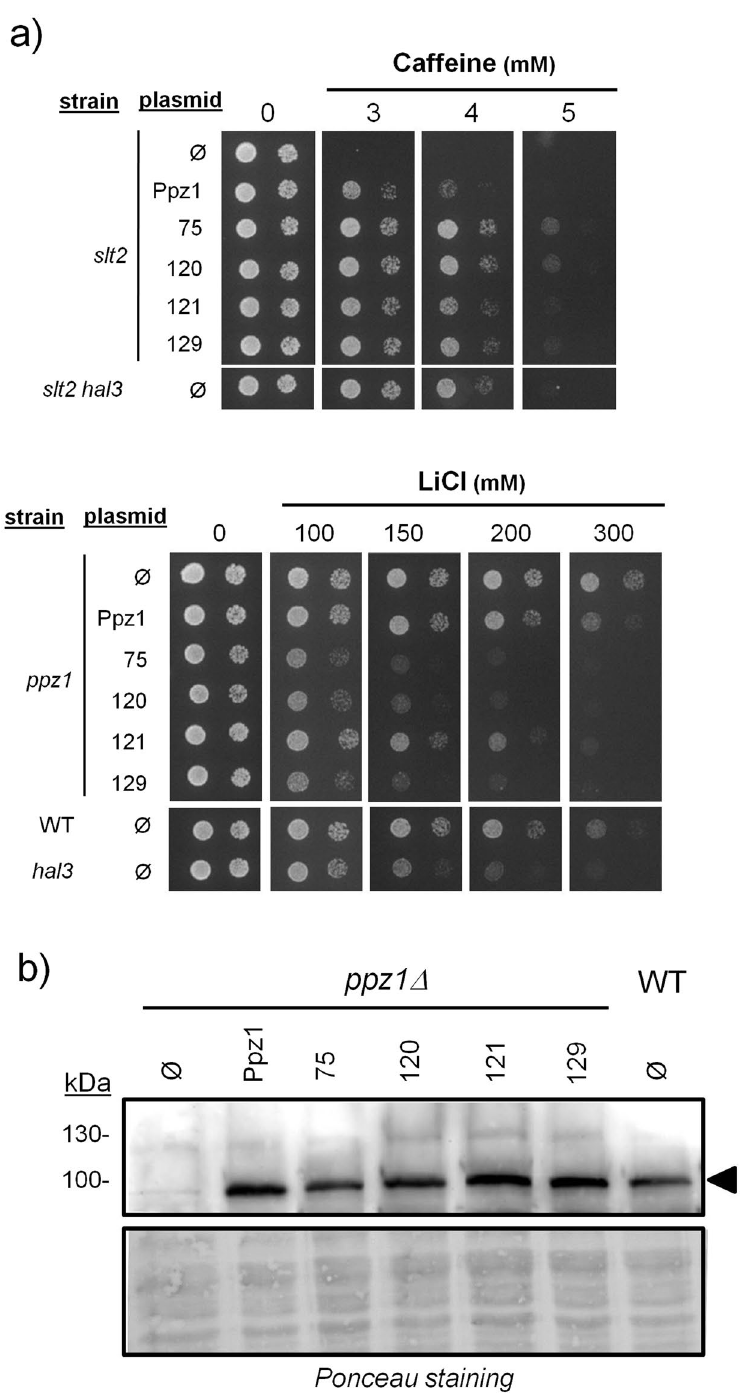
Figure 5. Phenotypic analysis and expression levels of selected Ppz1 versions carrying two amino acid changes. ( a ) Yeast strains were transformed with the diverse versions of Ppz1 and cultures spotted in the presence of various concentrations of caffeine or LiCl, as in Figs 1 and 2. Pictures were taken after 72 h. ( b ) Protein extracts (40 μ g) were analyzed as described in Fig. 2b. Ø, empty plasmid; WT, wild